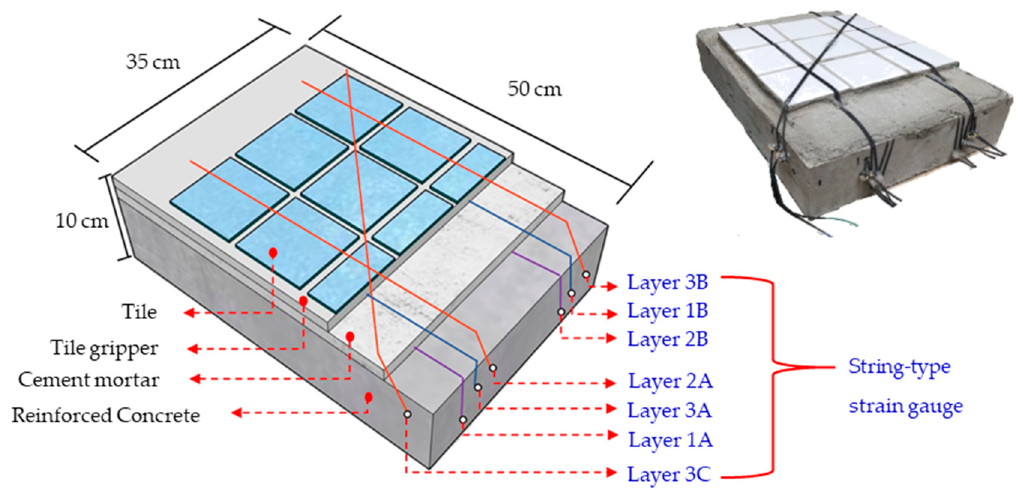
Figure 7. String-type strain gauge layout on the reinforced concrete specimen.